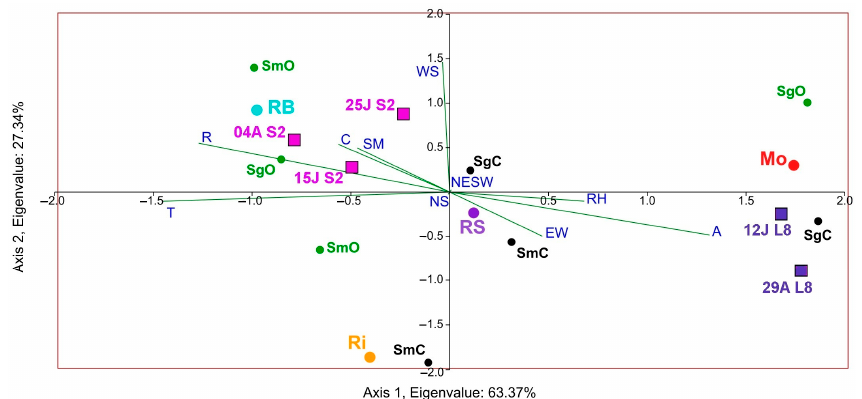
Figure 11. Composite CCA. Impact of factors on the NDVI calculated using Sentinel-2 (S2 in dates 04A: 4 August, 25J: 25 July, and 15J: 15 July) and Landsat-8 (L8 in dates: 29A: 29 August and 12J: 12 July) and species richness in musts (Sm) and grapes (Sg) concerning the DOs (Monterrei, Mo; R í as Baixas, RB; Ribeira Sacra, RS; Ribeiro, Ri) and farming systems (organic (O), in green and conventional (C), in black). Factors: canopy (C), vineyard orientation (EW, NS, NESW), elevation (A), and soil management (SM), and monthly averages of relative humidity (RH), wind speed (WS), rainfall (R), and temperature